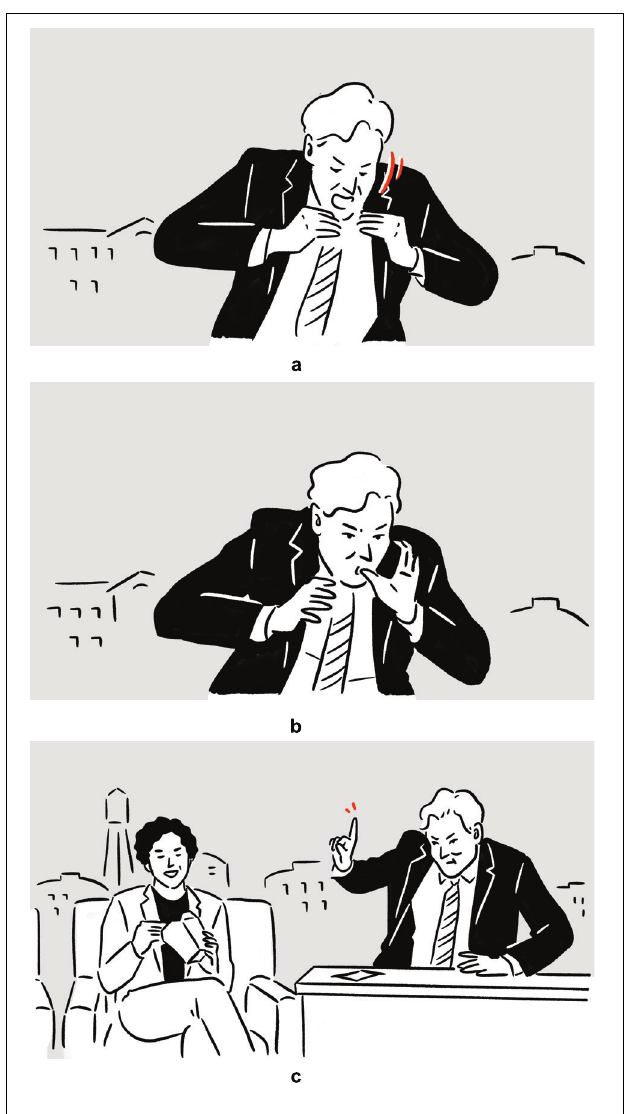
FIGURE 16 | Depictions in